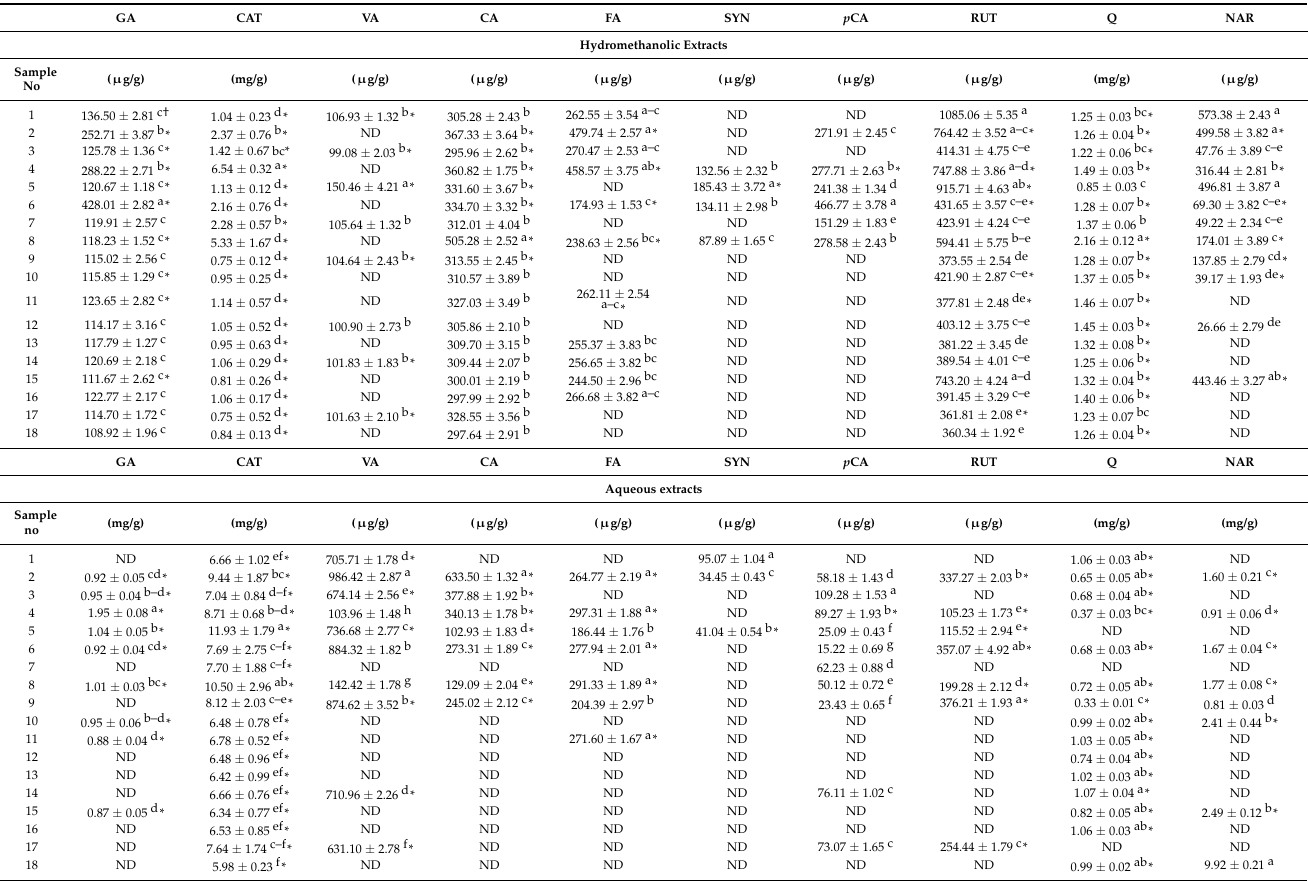
Table 4. Phenolic compounds in W. somnifera L. samples (mean ± standard